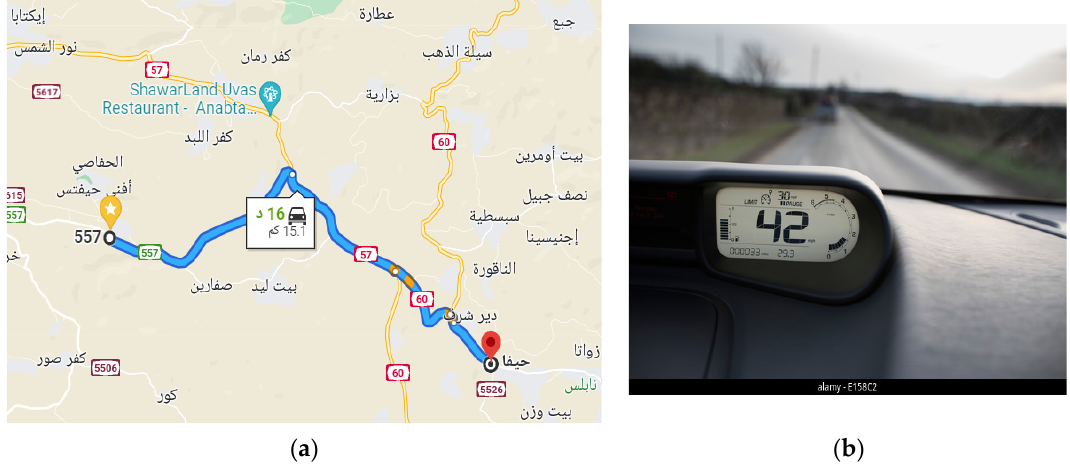
Figure 5. ( Left ): The trajectory of the vehicle during the experiments. The road is between Nablus city and Tulkarem city. The distance is 15 km. ( Right ): The digital speed meter used to record the vehicle speed.